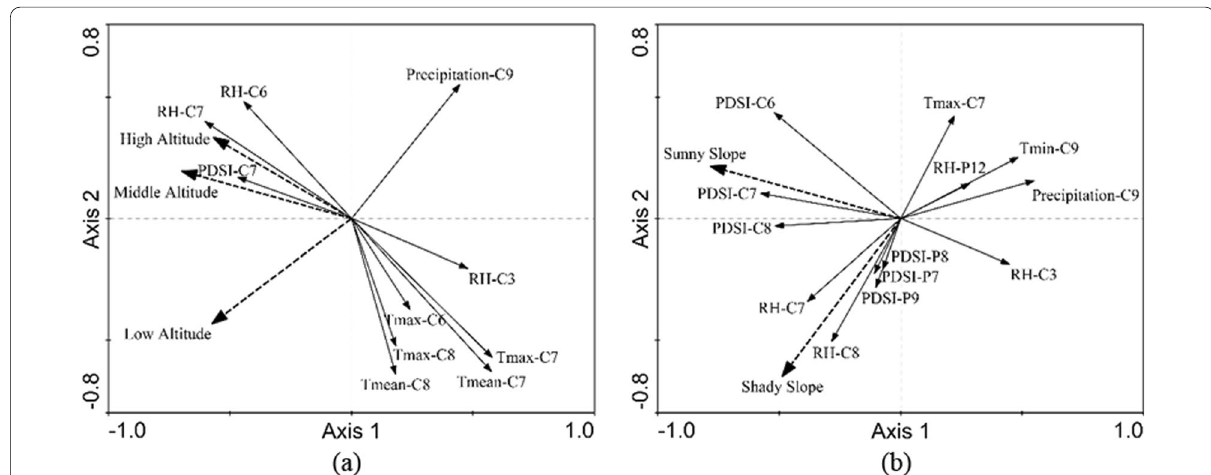
Fig. 9 Redundancy analysis (RDA) for the chronologies and the monthly climatic factors at different altitudes ( a ) and slopes ( b ). Significant ( p < 0.05) climatic factors are indicated by solid line arrows and named as “the climatic factor-corresponding month” (e.g., the mean temperature in July of the current year named as Tmean-C7). Arrow (vector) length and the cosine of the angle between two vectors depict the magnitude of variables and their correlation. The longer the vector, the more important the climatic factor. Vectors crossing at sharp angles, obtuse angles, and right angles, respectively, indicate a positive correlation, a negative correlation, and a near-zero